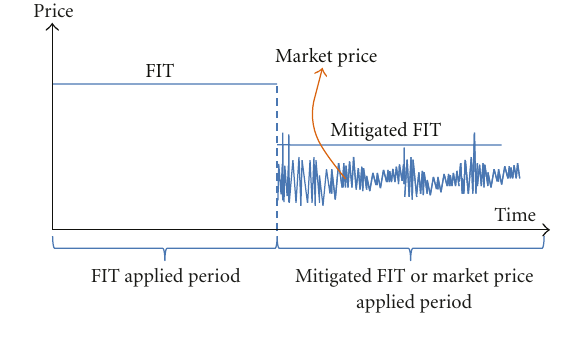
Figure 6: ECX CFI futures contracts.